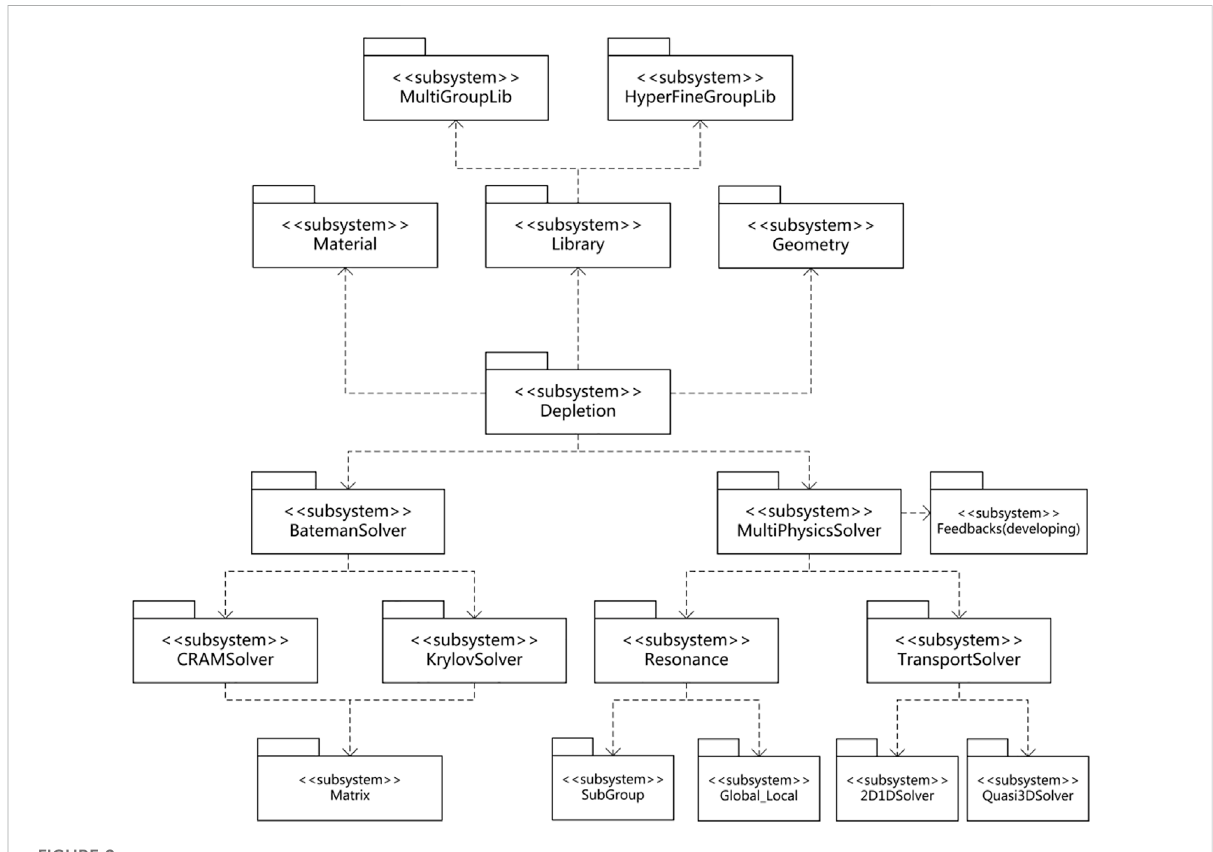
FIGURE 2 Design of the SHARK program framework for